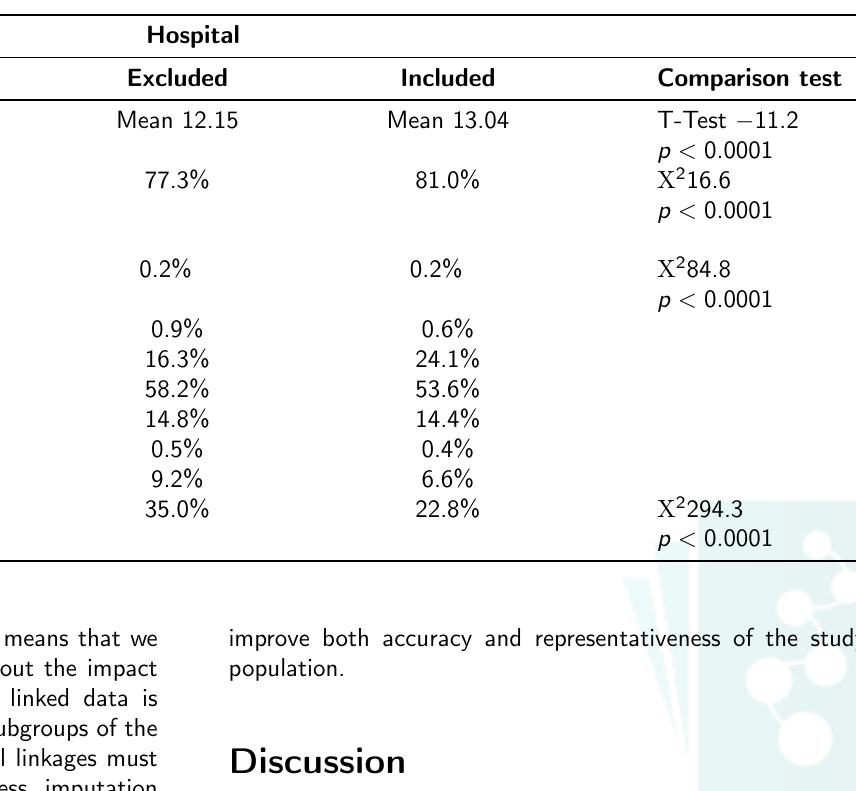
Table 6: Deterministic linkage statistics in the longitudinal sports and recreation injury study – differences in hospital